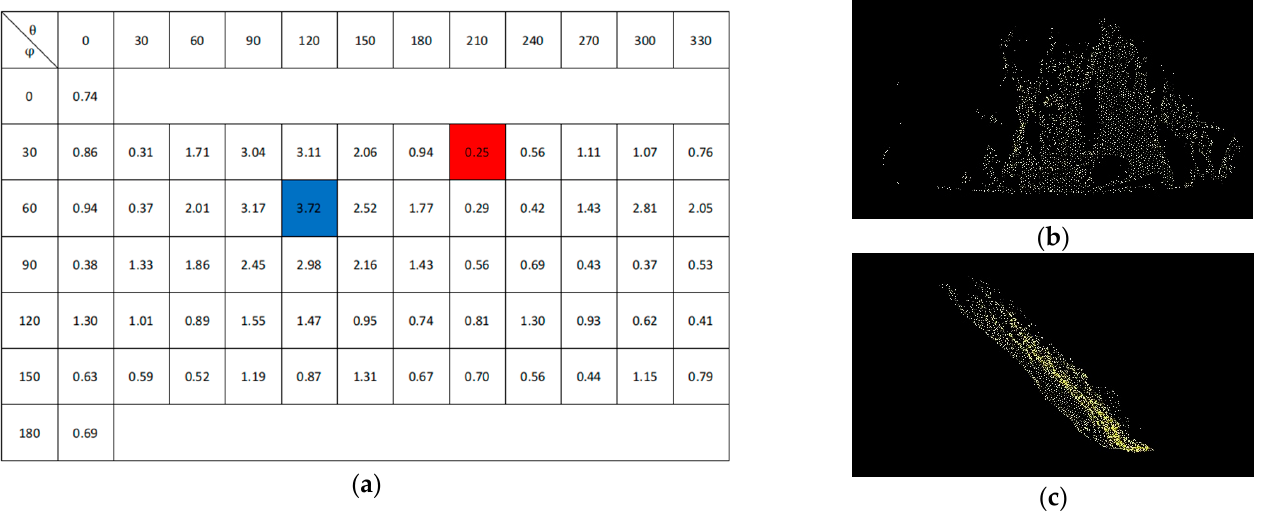
Figure 3. Best viewpoint selection: ( a ) entropy comparison diagram; ( b ) Best viewpoint; ( c ) Worst viewpoint.